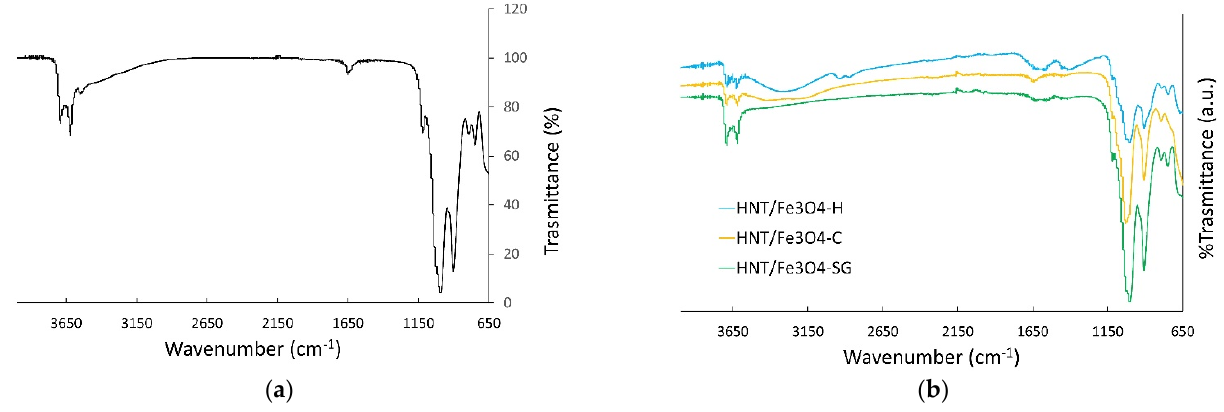
Figure 2. FT-IR spectra of ( a ) the commercial halloysite, and ( b ) the HNT/Fe 3 O 4 composites.